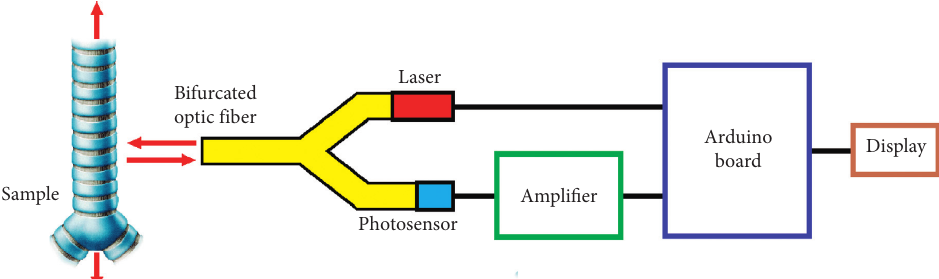
Figure 3: Block diagram of the prototype that measures optical response caused by tension in a porcine trachea model.